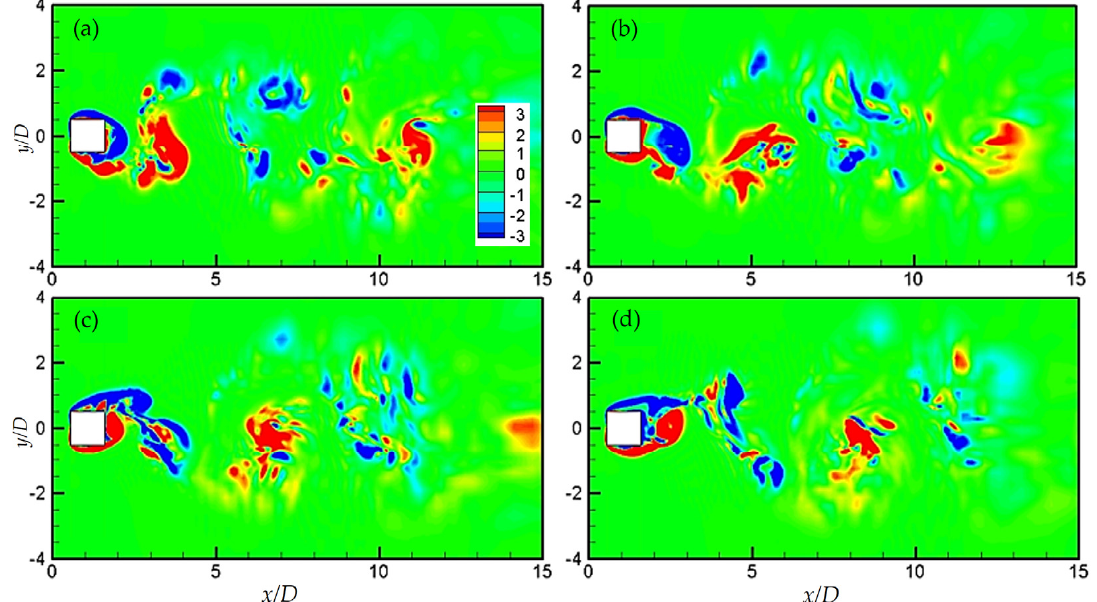
Figure 13. Instantaneous contours of the spanwise vorticity 𝜔 (cid:3053) for α = 15° on the ( x , y ) plane at z = 4 D within one vortex shedding period T. ( a ) t = 0; ( b ) t = T/4; ( c ) t = 2T/4; ( d ) t = 3T/4.